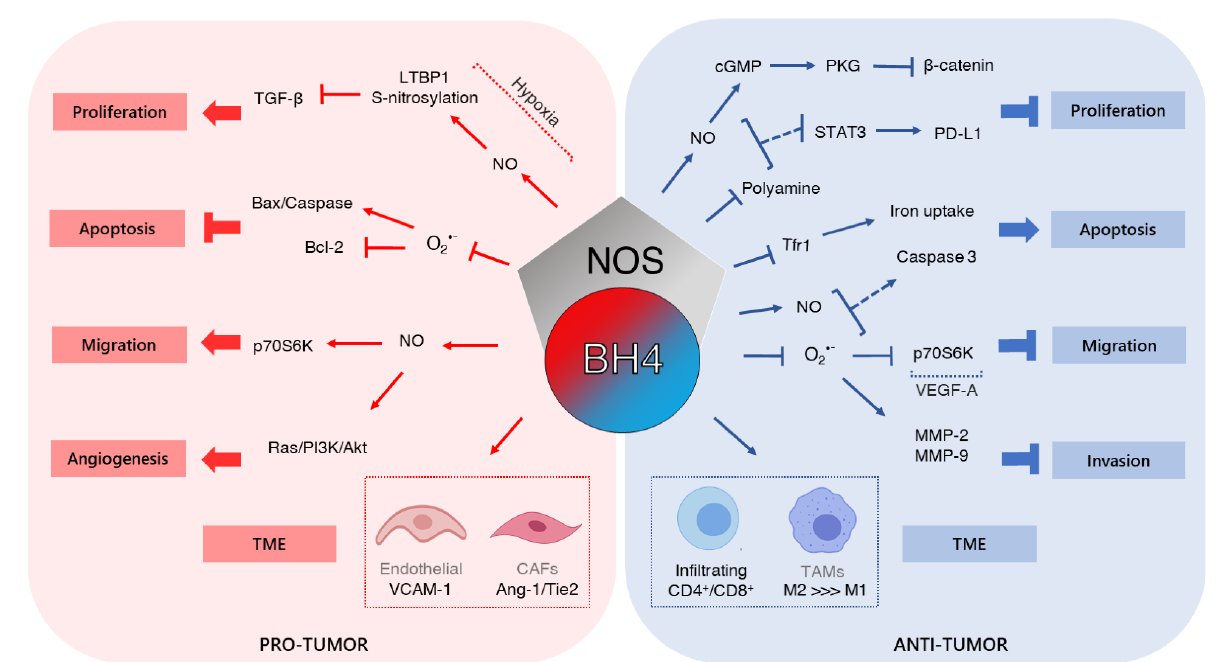
Figure 3. Schematic presentation of the dual mechanisms of the BH4/NOS axis in acquired capabilities along with cancer progression. BH4 pro-tumor activity comprises proliferation induction through TGF- β pathway activation, apoptosis abrogation by Bax inhibition and Bcl-2 increase, p70S6K-dependent promotion of migration, and angiogenesis stimulation by Ras/PI3K/Akt signaling. As anti-tumor, BH4/NOS axis induces apoptosis due to caspase-3 activation and iron uptake decrease, reduces proliferation by decreasing polyamine concentration, and impairs migration and invasion by reducing VEGF-A/p70S6K pathway and MMP-2 and MMP-9 activity, respectively.